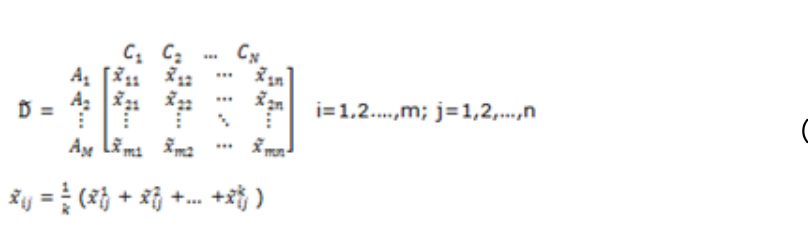
Table 1. The linguistic scale and corresponding triangular fuzzy numbers Step 2: Construct the fuzzy decision